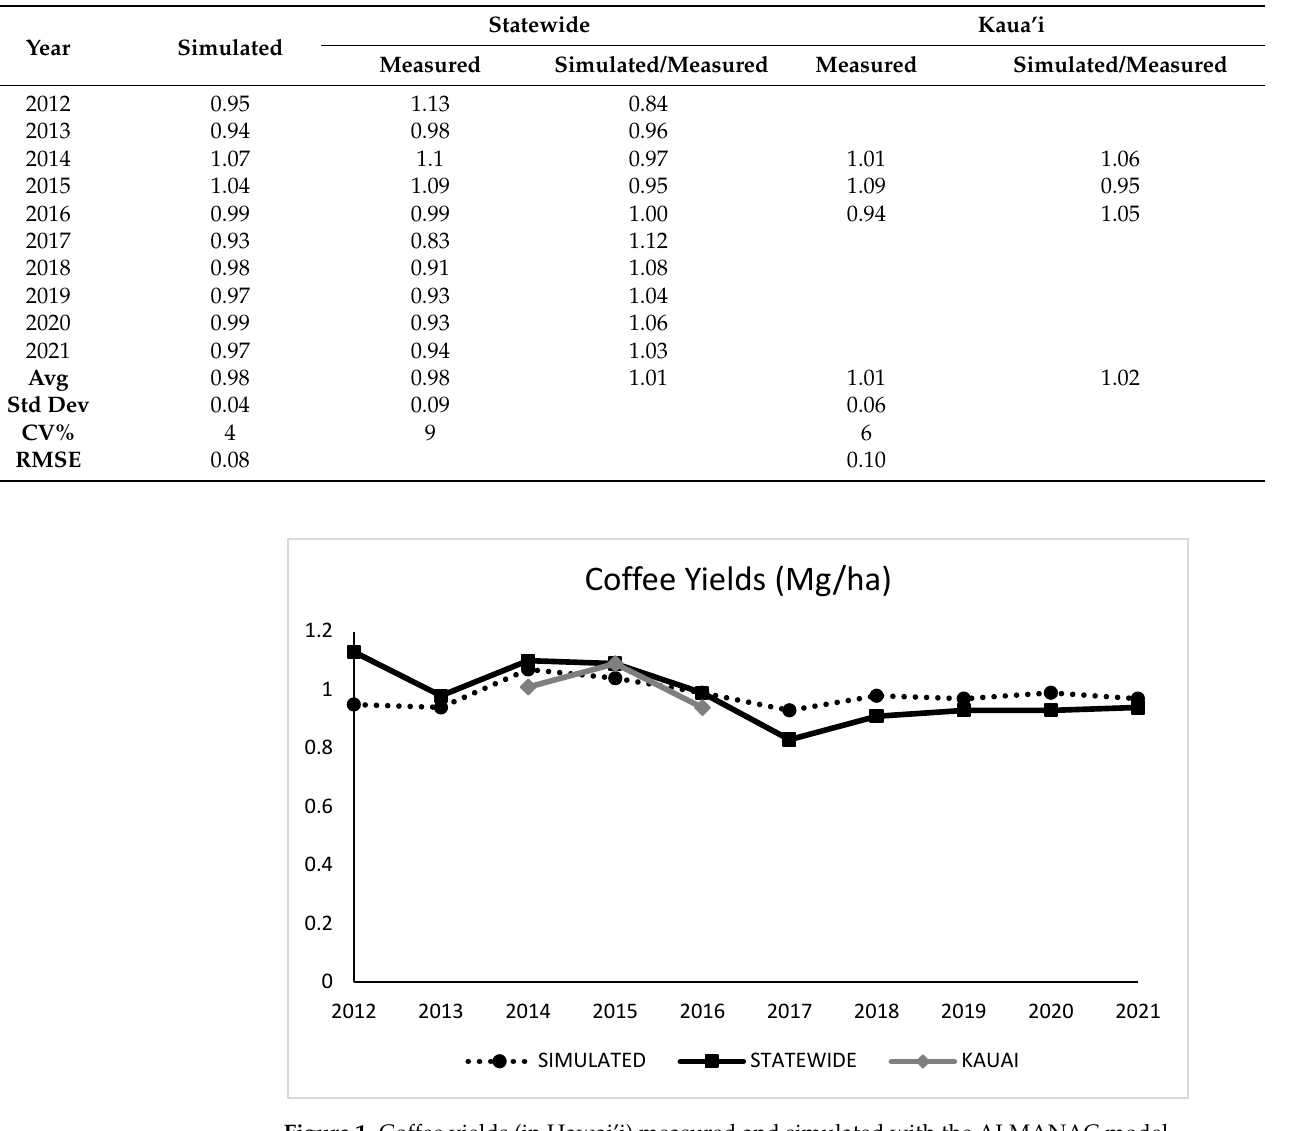
Figure 2. Cocoa yields (in Ghana) measured and simulated with the ALMANAC model. Table 9. Sensitivity analysis of yield responses to changes in rainfall. Coffee Yields (Mg/ha) Rainfall Changes Standard Deviation (%)